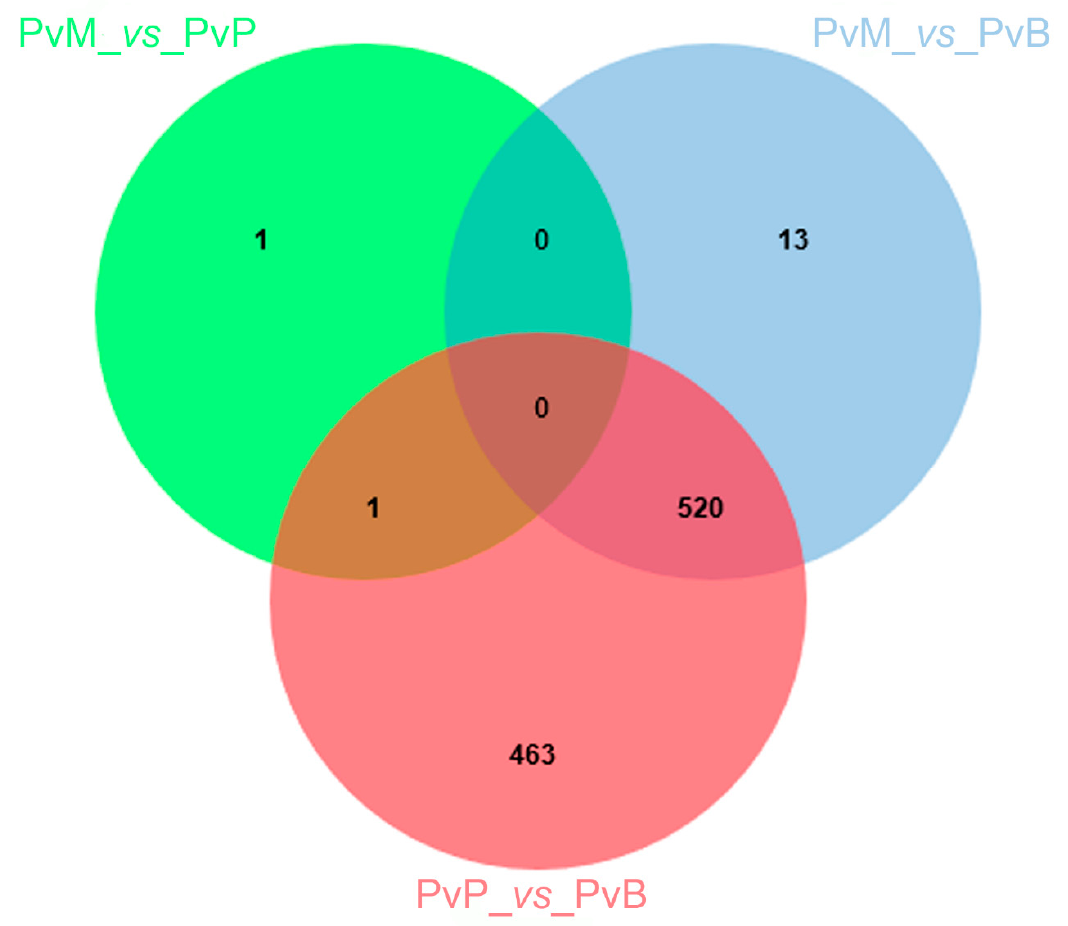
Figure 1. Venn diagram illustrating the comparison between genes di ff erentially expressed (DEGs) by Plasmopara viticola (Pv) following inoculation on Mgaloblishvili (M) and Pinot noir (P) (PvM_ vs